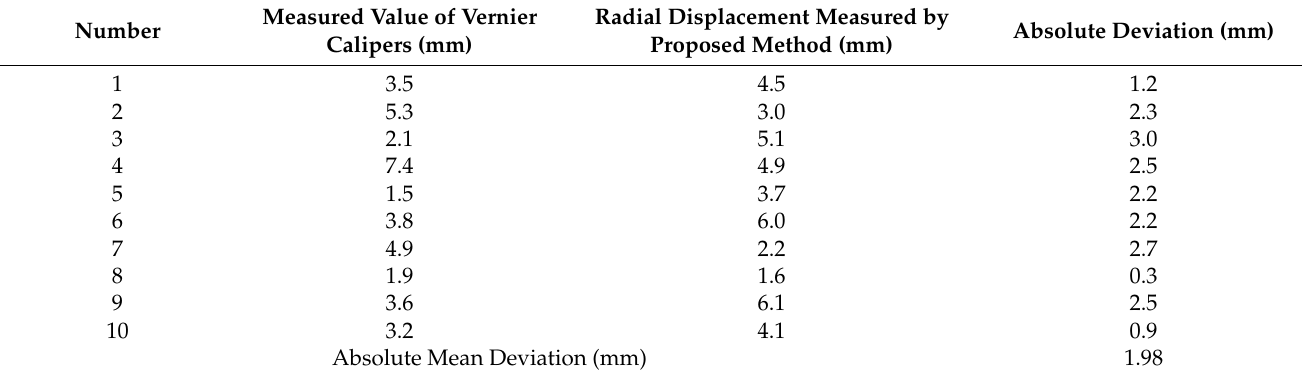
Table 2. Radial displacement absolute accuracy